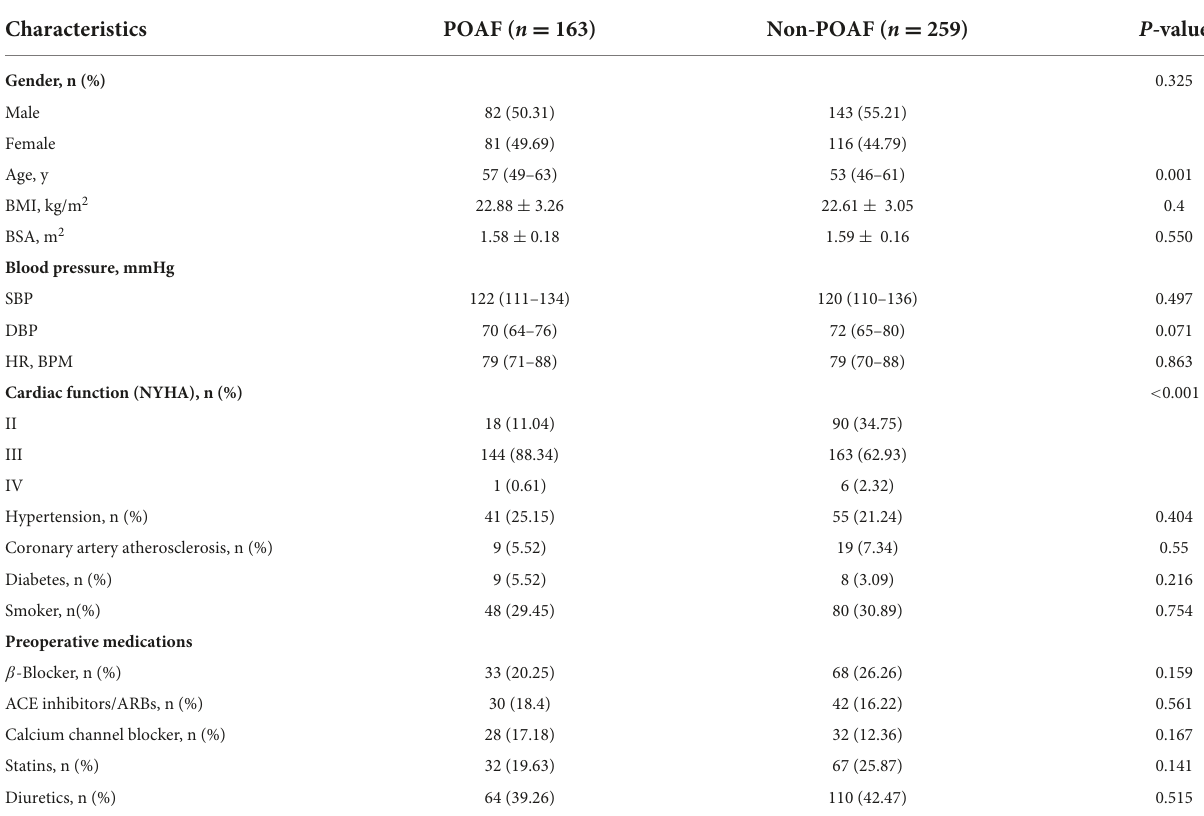
TABLE 1 Baseline characteristics of patients with or without